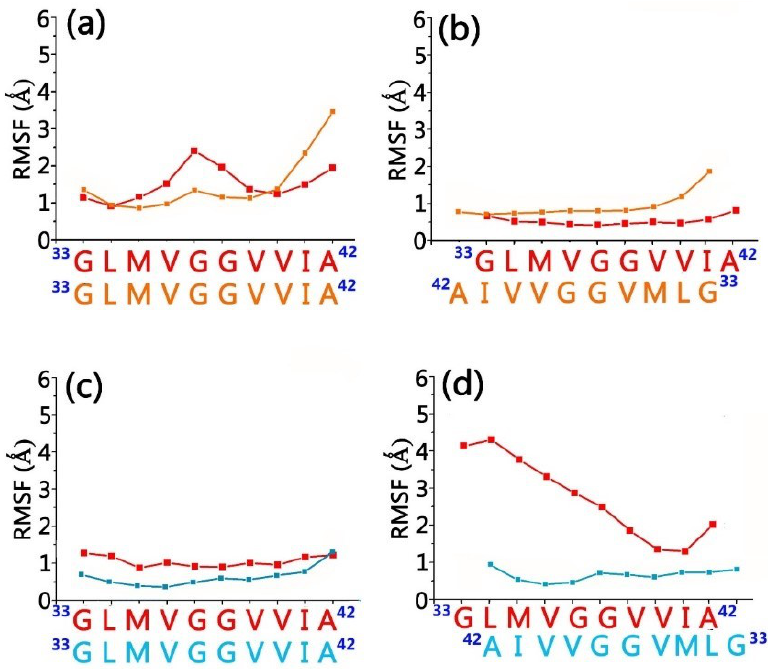
Figure 7. Residue-based RMSF profiles indicated that CDR3 loop cannot be stabilized when binding on the sidechain surface of 3S A β amyloid structure. ( a ) 2U_Backbone; ( b ) 2U_SideChain; ( c ) 3S_Backbone; and ( d ) 3S_SideChain gammabody-A β complexes. For easy comparison, the residue numbers in grafted A β motif in gammabody are set as their original residue number in A β peptide. Color Codes: the grafted A β residues in gammabody (red), 2U A β aggregates (orange), and 3S A β aggregates